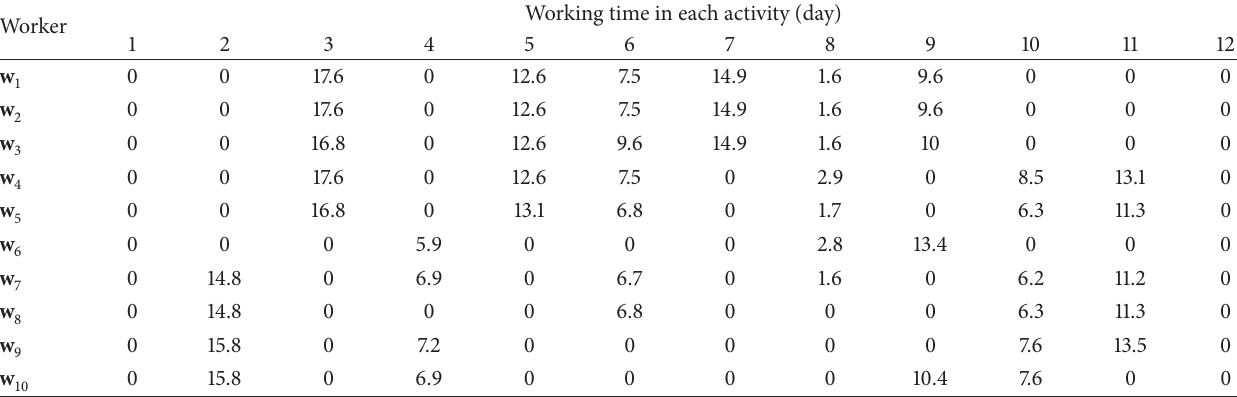
Table 5: Details on working time with top level of induced